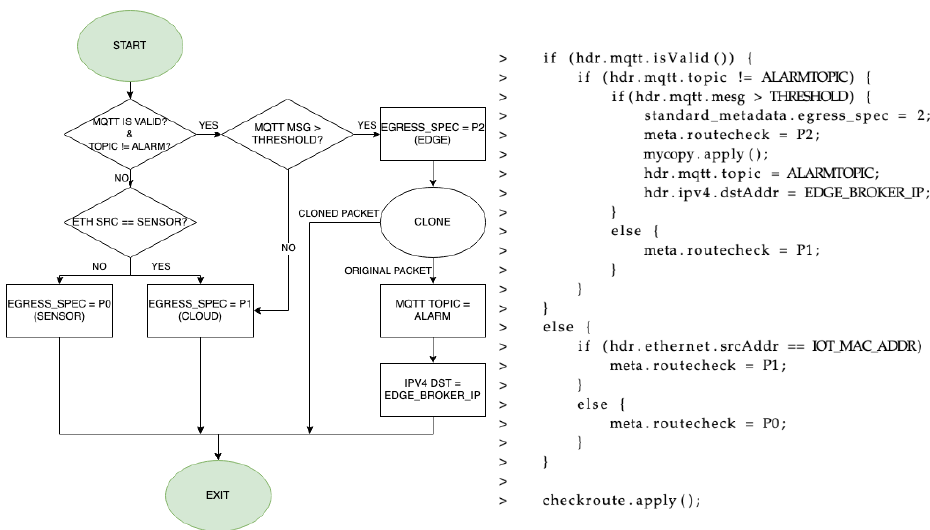
Figure 6. Flux diagram and code for the ingress